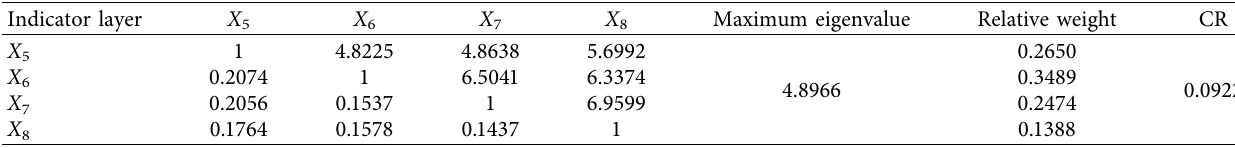
Table 11: Judgment matrix and weights of indicator layer indices in criterion B